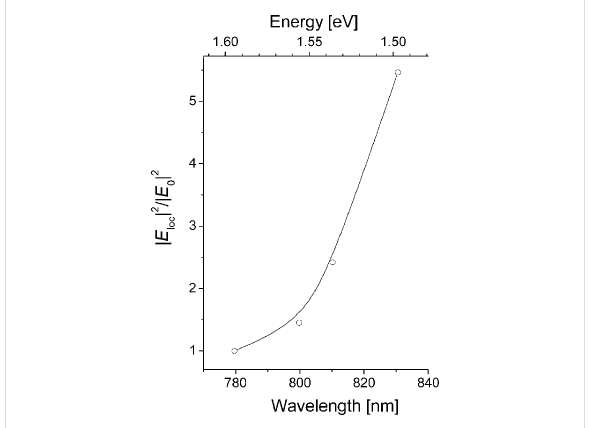
Figure 5: Near-field intensity E loc2 / E 02 in the hot spots inferred from the ratio of SEHRS and SERS signals measured for crystal violet on silver nanoaggregates while using excitation wavelengths between 780 and 830 nm. Reprinted with permission from [18]. Copyright 2013